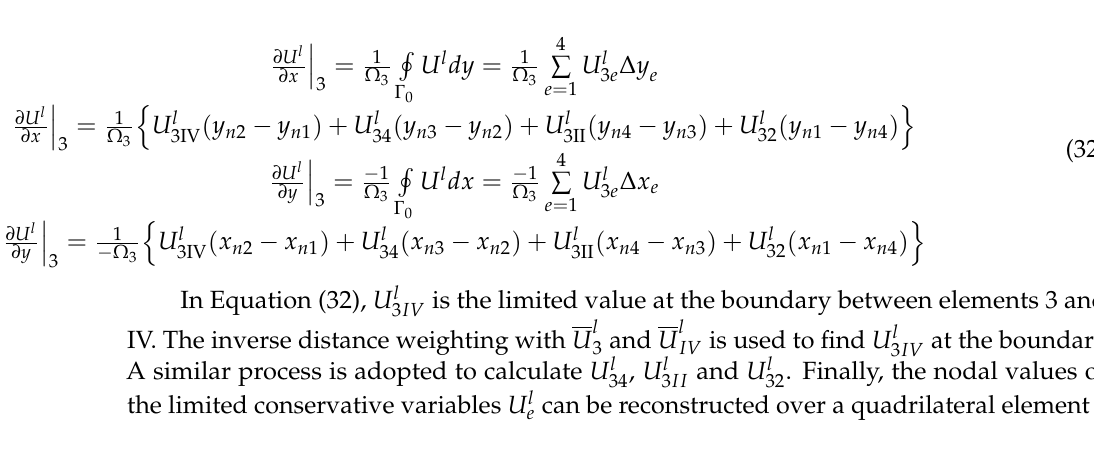
Figure 2. Discontinuous elements used in the assessment of the limited gradient for element